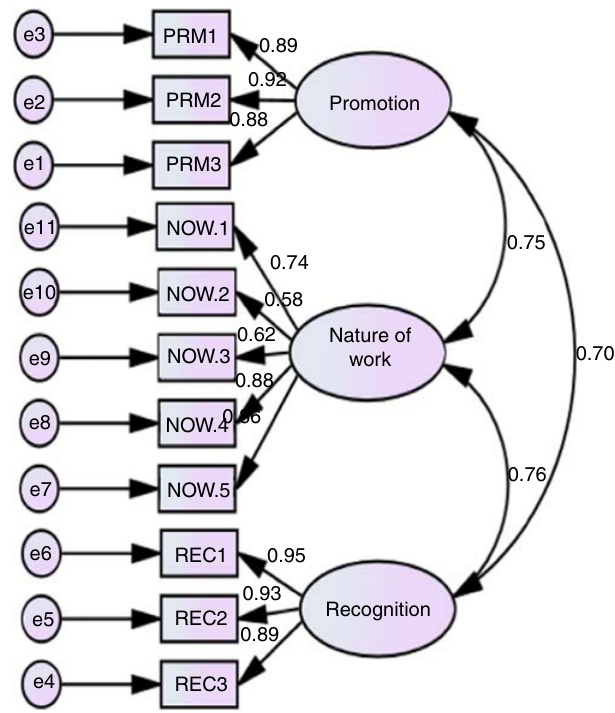
Figure 1. Results of confirmatory factor analysis (CFA) for Intrinsic factors of Job